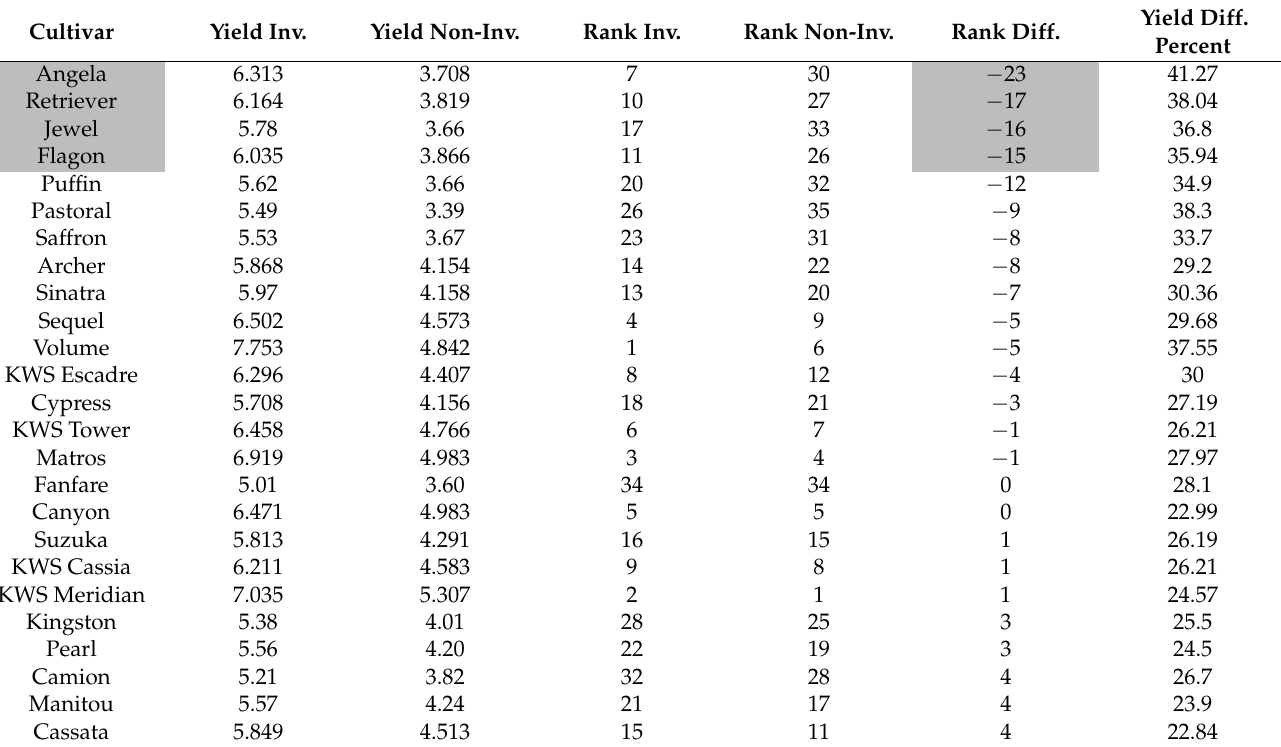
Table 12. Ranking of 35 winter barley cultivars grown in the 2012 trial by the difference between their inversion and non-inversion yield ranking. Cultivar Yield Inv. Yield Non-Inv. Rank